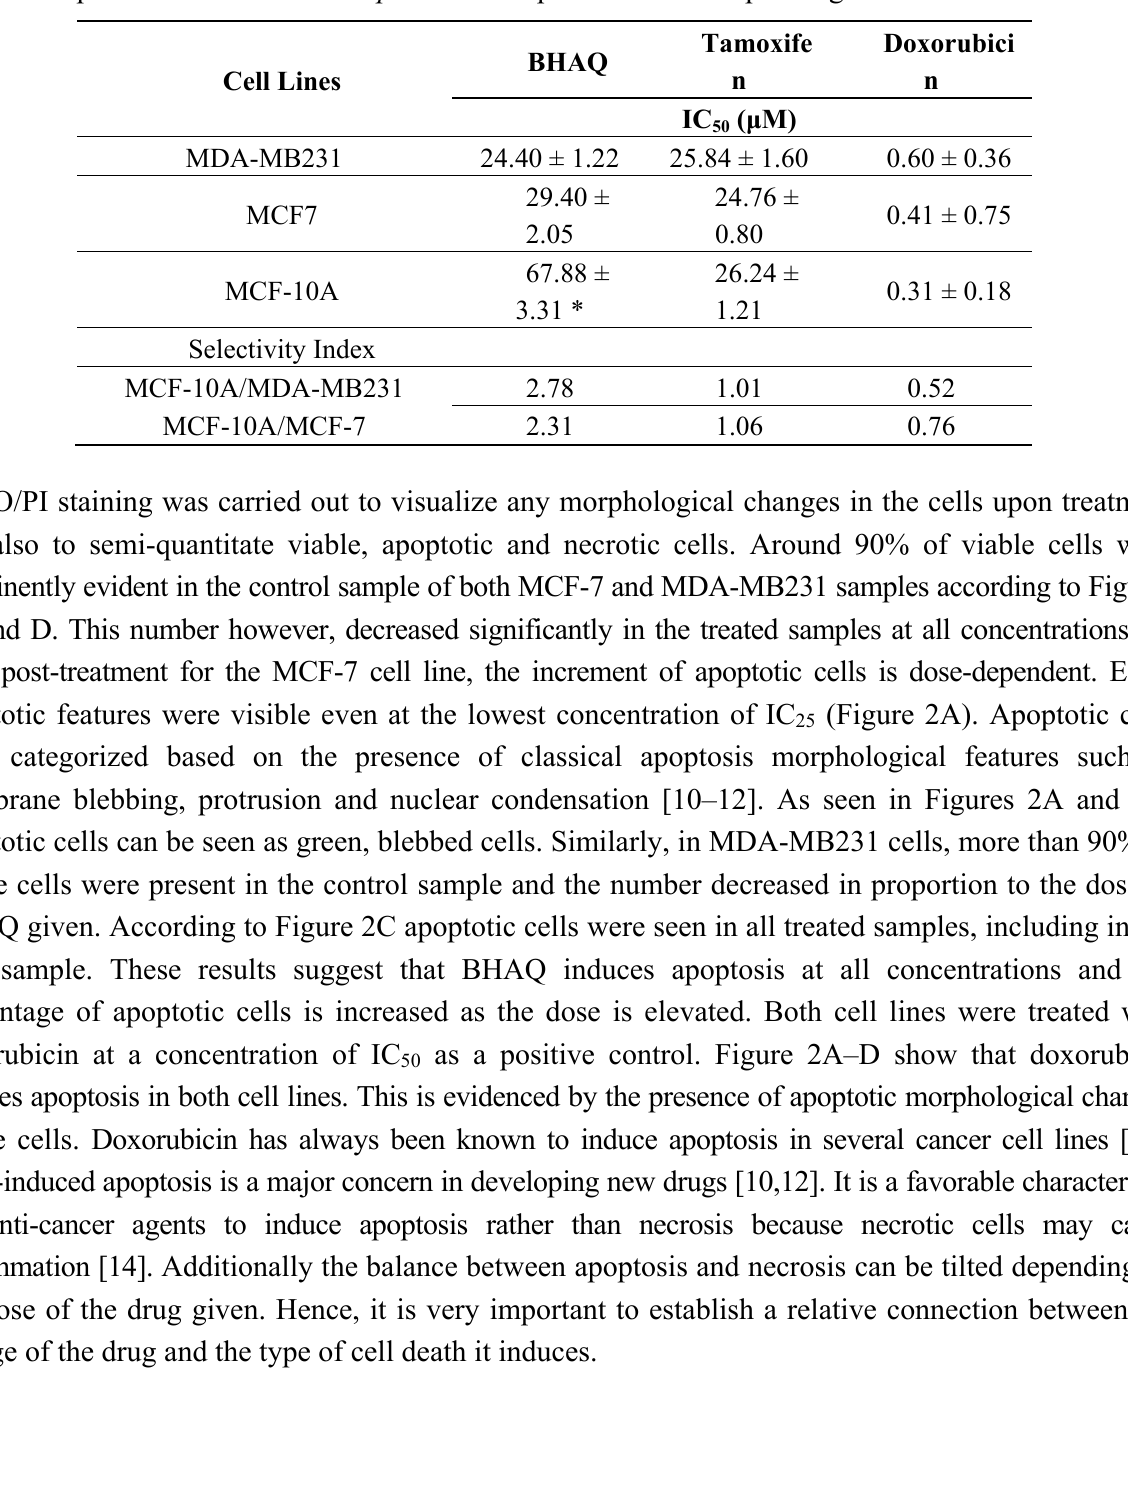
in cancerous cell line. All data 50